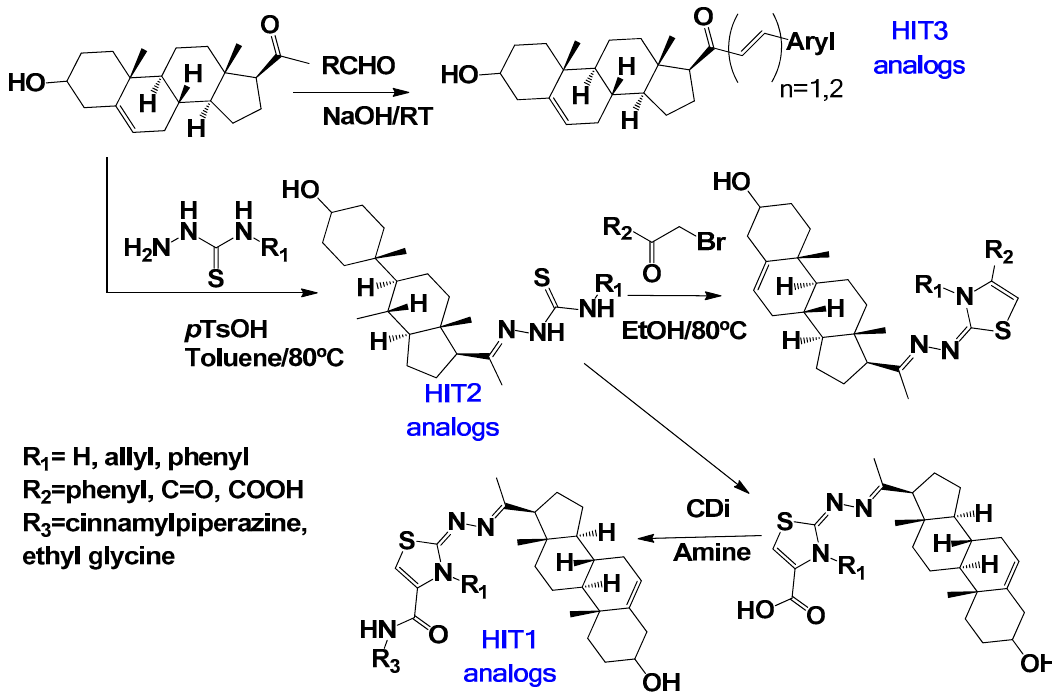
Figure 2. Synthetic procedure for steroidal arylideneketones and thiazolidenehydrazines. RT: Room temperature (25 °C), CDi: 1,1’-carbonyldiimidazole.